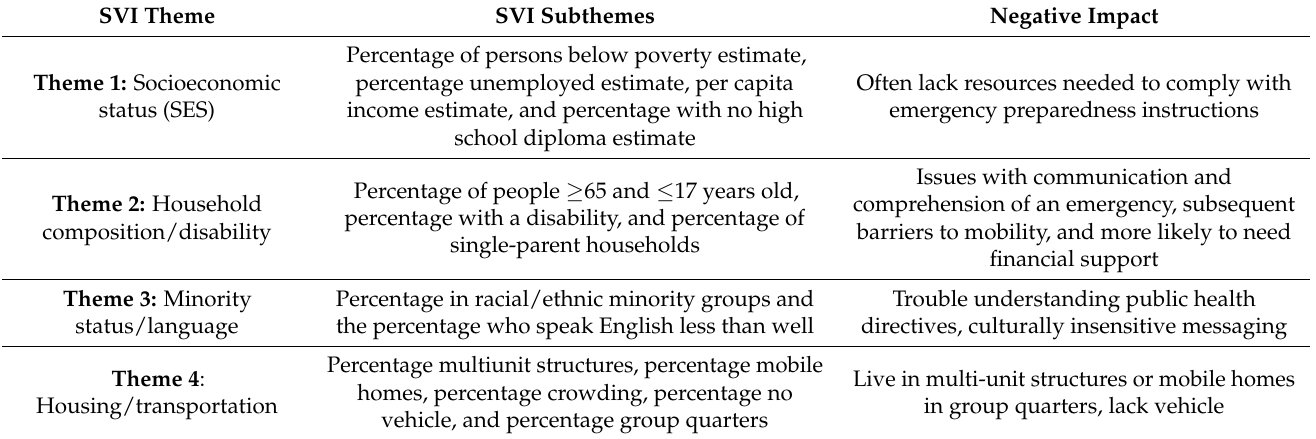
Table 1. CDC SVI 2016 themes and subthemes